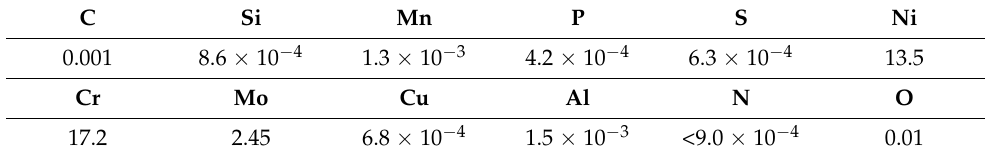
Table 1. Chemical composition of extra-high-purity type 316 (316EHP) stainless-steel (mass %).